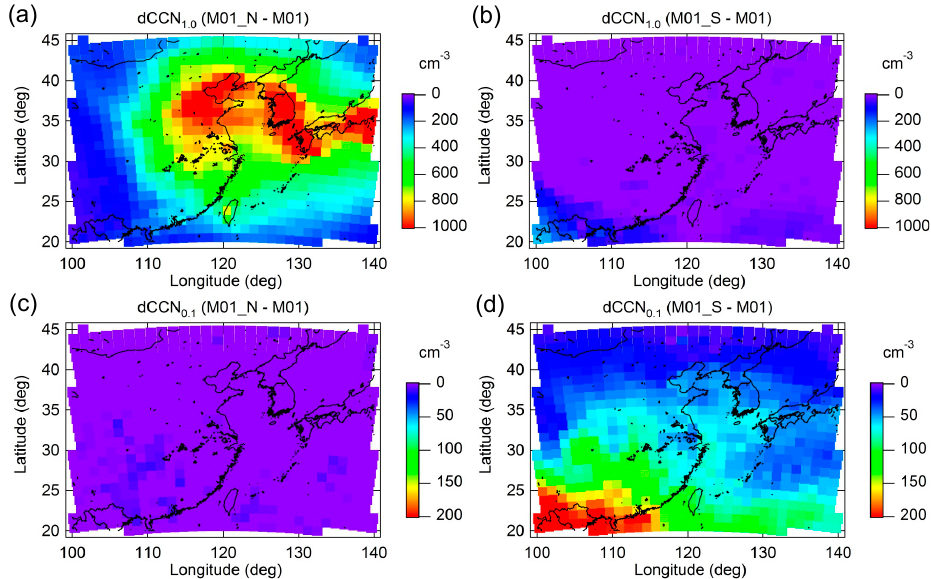
Figure 5. The period-averaged dCCN concentrations at a sigma level of 0.895 ( ∼ 1km). dCCN is defined as the difference in the CCN concentration between M01_N and M01 (left panels, (a) CCN 1 . 0 and (c) CCN 0 . 1 ) or between M01_S and M01 (right panels, (b) CCN 1 . 0